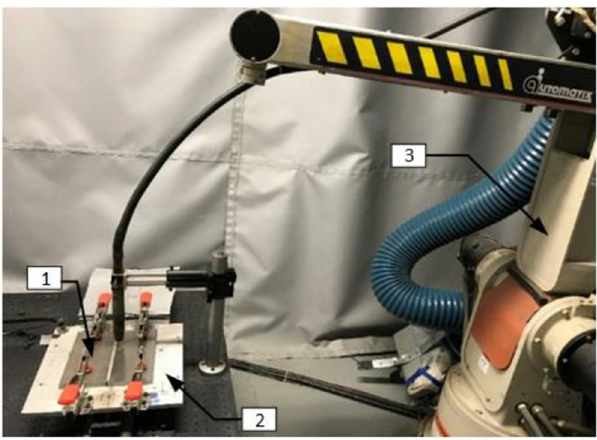
Fig. 10. Laser/EMAT stress measurement setup (1 – laser;